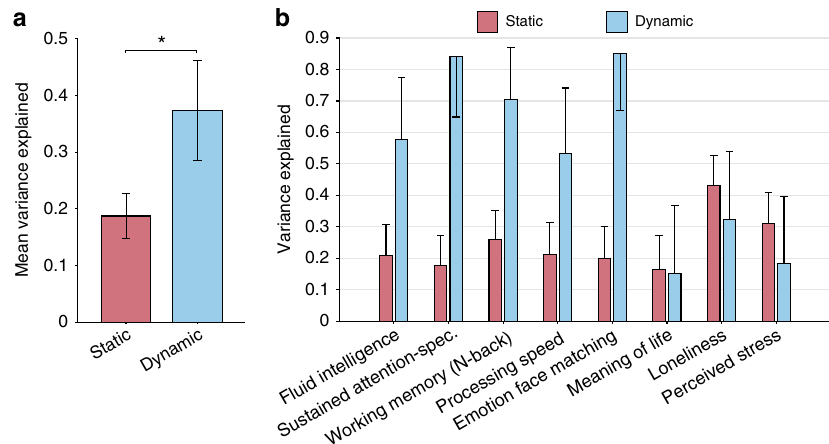
Fig. 1 Dynamic FC explains more behavioral variance than static FC. a On average over 58 behavioral measures, dynamic FC (blue, 37%) explains more behavioral variance than static FC (red, 19%) ( p = 8.31 × 10 − 4 ; two-tailed t -test). b Variance explained for eight representative measures. Here, static FC utilizes Pearson ’ s correlation, while dynamic FC utilizes the coef fi cient matrix of a fi rst-order autoregressive model. Error bars indicate standard deviation (SD) of the estimates